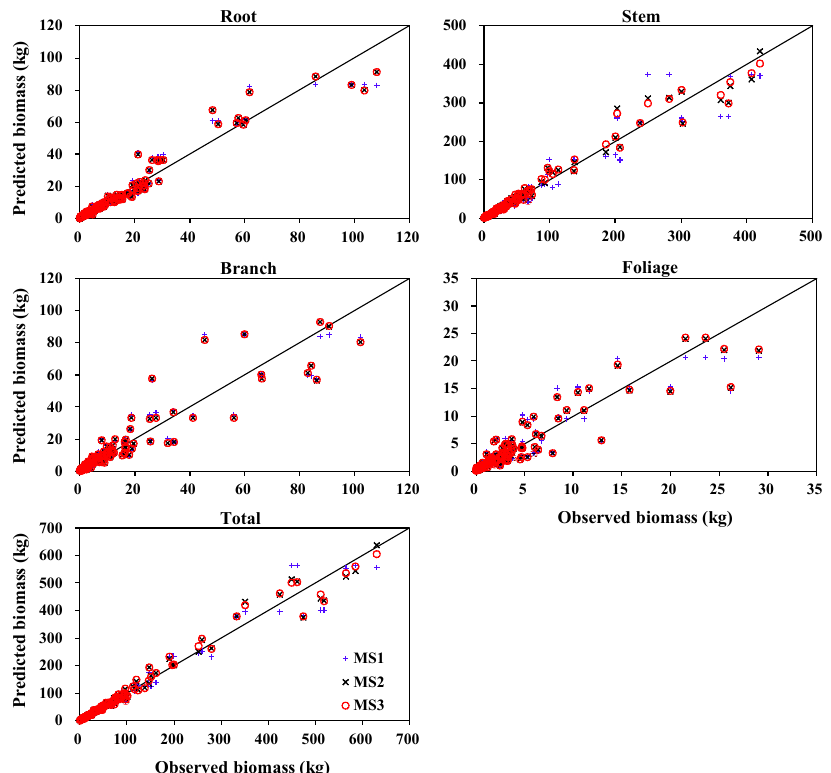
Figure 3. The observed and predicted values for the root, stem, branch, foliage, and total biomass of the three additive biomass model systems (MS1, MS2, and MS3).